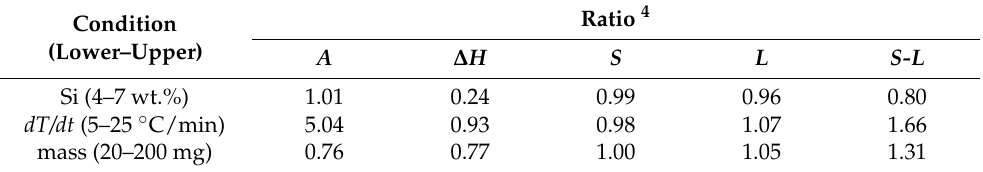
Table 5. Comparison of the variables area between DSC curve and baseline ( A in W ◦ C/g), enthalpy change ( ∆ H in V/g ), solidus ( S in ◦ C), liquidus ( L in ◦ C) and semisolid interval ( S–L in ◦ C) for extreme (lower and upper) values of Si content, heating rate and sample